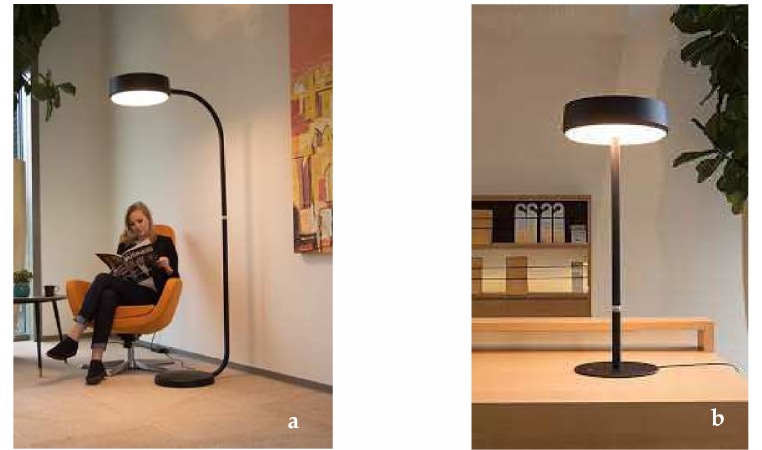
Figure 2. ( a ) The Sparckel, type Bright Brenda; ( b ) The Sparckel, type Jolly